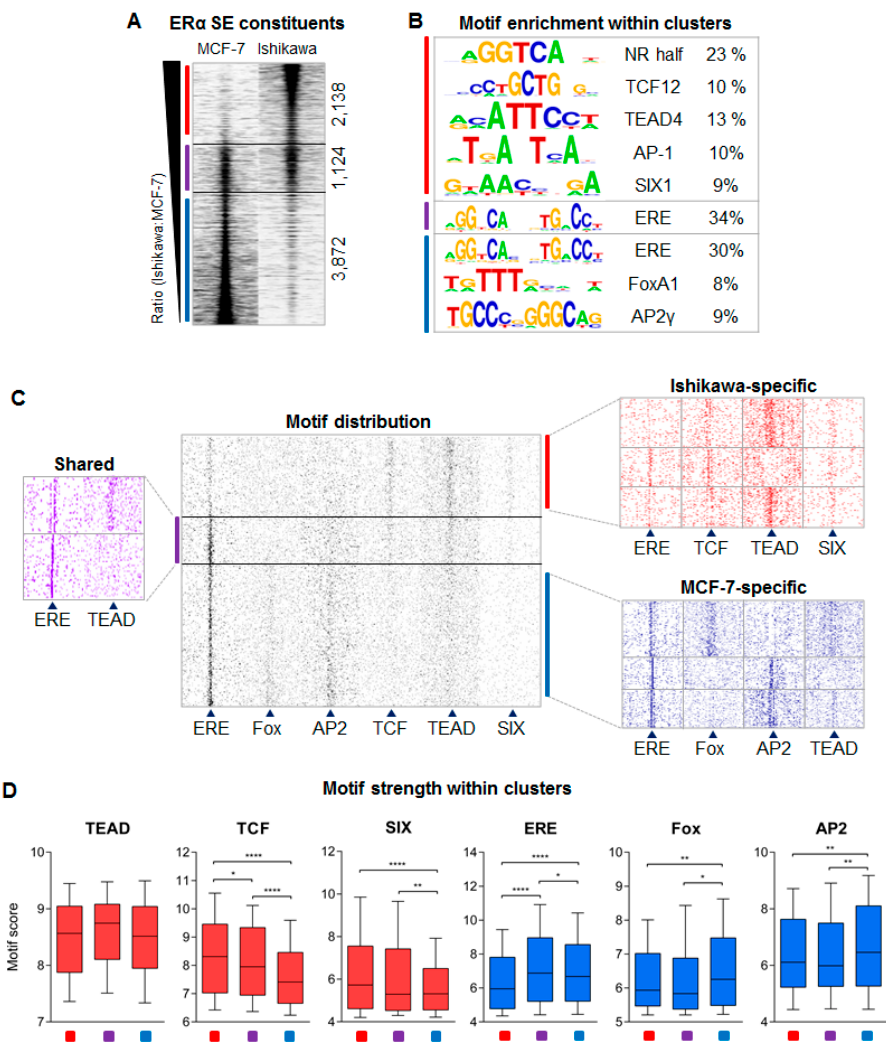
Figure 2. ER α -driven super-enhancer constituents show distinct binding patterns and motif preferences in MCF-7 and Ishikawa cells. ( A ) Read distribution plot showing ER α density on ER α -driven super-enhancer (SE) constituents derived from MCF-7 and Ishikawa cells in 2-kb frames. Peaks were sorted based on the ratio of RPKM (reads per kilobase per million mapped reads) values calculated from Ishikawa and MCF-7 cells and were separated into three different clusters: the red line represents Ishikawa-specific constituents ( n = 2,138), the purple line represents shared constituents ( n = 1,124), and the blue line represents MCF-7-specific SE constituents ( n = 3,872). ( B ) The enriched motifs and their percentages within the target regions of the three clusters. ( C ) The motif distribution plot of ERE, Fox, AP2, TCF, TEAD, and SIX motifs in 1.5-kb frames around the summit position of ER α -driven SE constituents in the same order as introduced in Figure 2A (middle). Colored heat maps represent shared and cell line-specific clusters when peaks were further clustered based on the presence or absence of the most frequent motifs. ( D ) Box plots showing the distribution of motif strengths within the three main clusters introduced in Figure 2A. The boxes represent the first and third quartiles, the horizontal lines indicate the median scores and the whiskers indicate the 10 th to 90 th percentile ranges. Paired t-test, * significant at p < 0.05, ** at p < 0.01, *** at p < 0.001, **** at p < 0.0001.